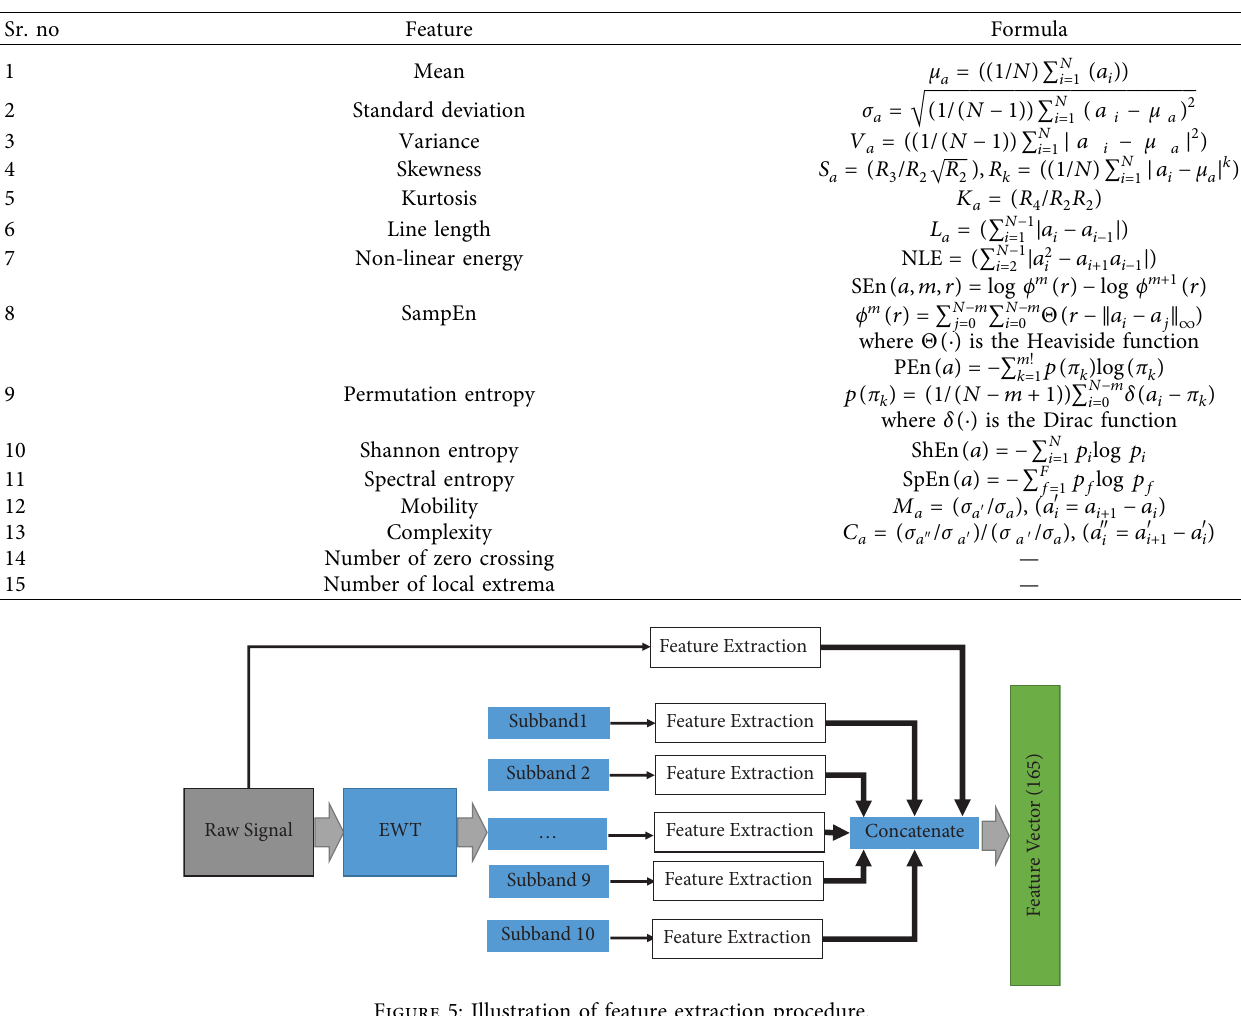
Table 3: A list of features extracted from raw EEG signal and its sub-bands.